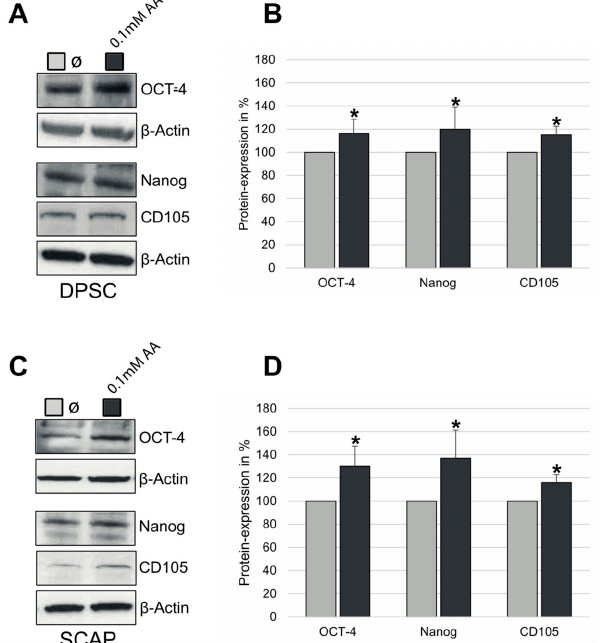
Figure 4. Protein expression of OCT4, Nanog, and CD105 in ( A , B ) DPSC and SCAP ( C , D ) treated with 0.1 mM AA. Means ±SD of three independent experiments; * p < 0.05 indicates statistical significance vs. Ø (0 mM AA).